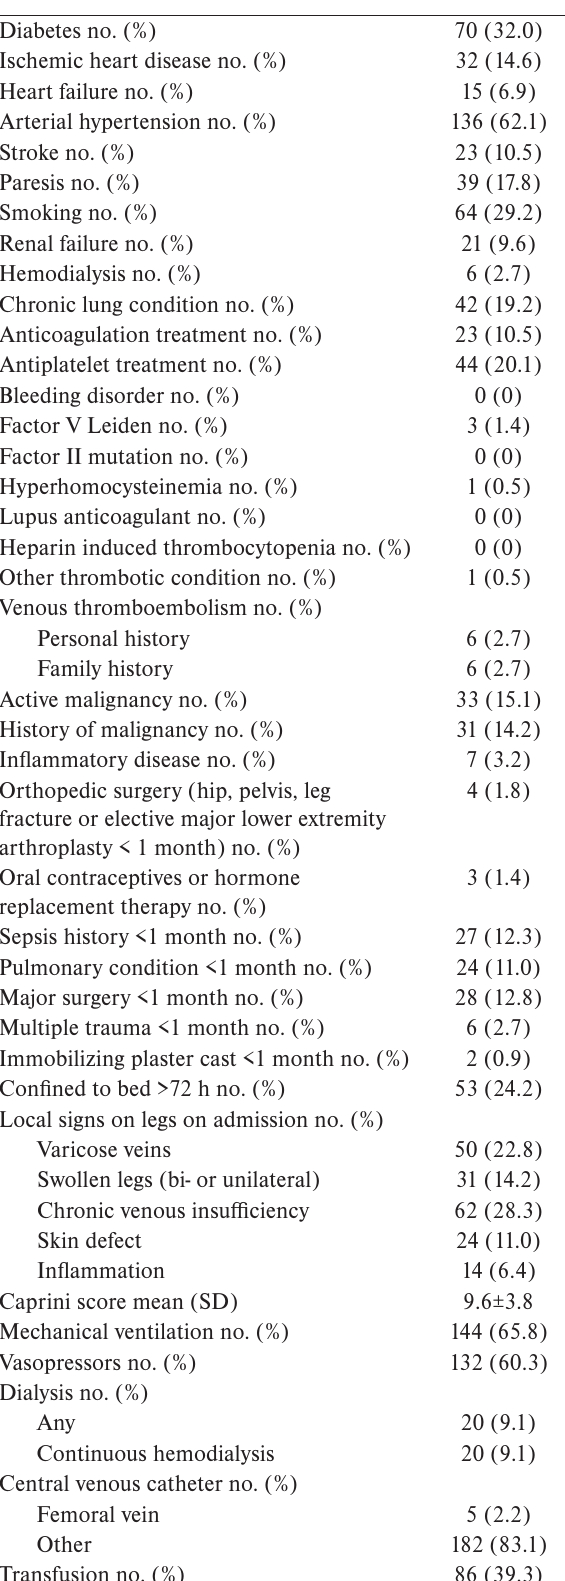
Table 2. Risk factors of deep vein